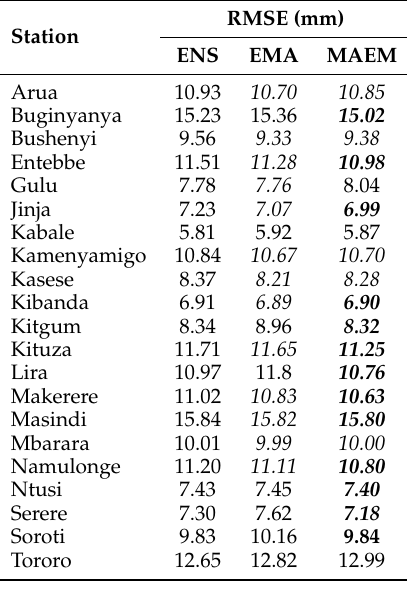
Table 4. Shows the ME (or Bias) for: ensemble mean (ENS); ensemble mean analogue (EMA) and multi–member analogue ensemble mean (MAEM). The bold values indicate a magnitude of ME less than 2.00 for all the three